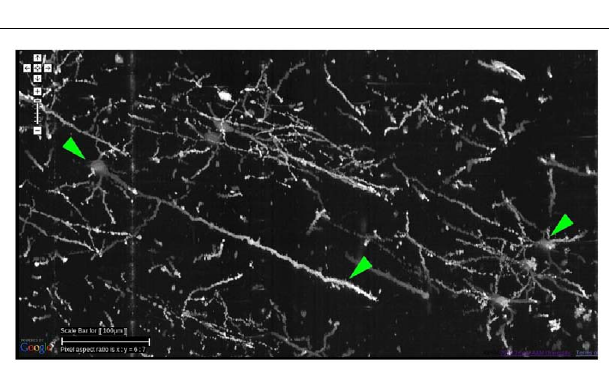
FIGURE 8 | Details from Golgi data set 1. Details from the Golgi data set 1 are shown at full resolution.This panel shows an overlay of 20 images, thus it is showing a 20- μ m-thick volume. Scale bar = 100 μ m.The arrow heads, from left to right, point to (1) the soma of a pyramidal cell in the cortex and (2) its apical dendrite, and (3) a couple of spiny stellate cells. Other pyramidal cells and stellate cells can be seen in the background. At this resolution, we can see dendritic spines as